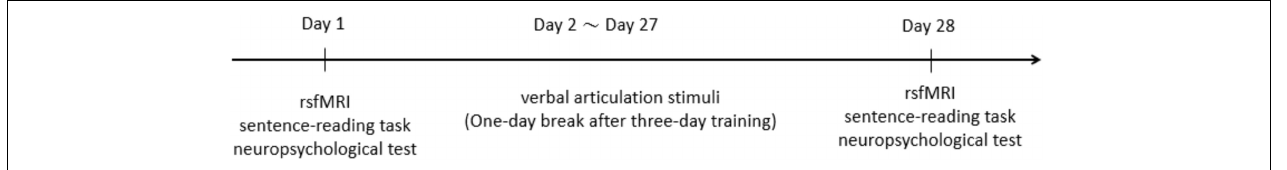
FIGURE 2 | Timing diagram of the scans and stimulus delivery.